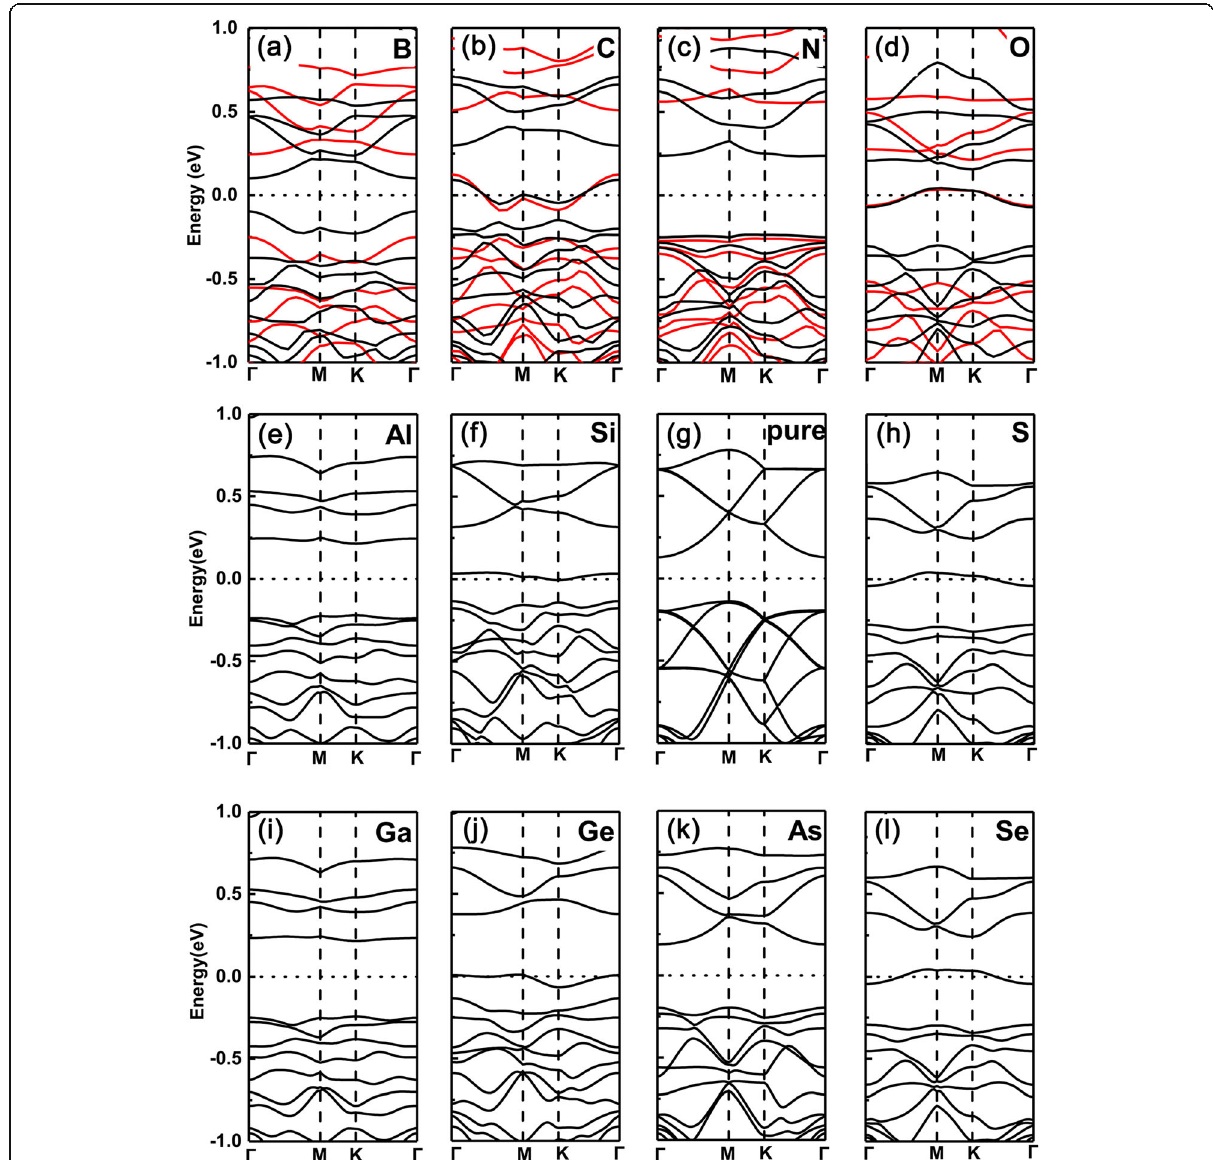
Fig. 3 Band structures of the various dopants in GeP 3 monolayer with substituting P atom. a B, b C, c N, d O, e Al, f Si, g P, h S, i Ga, j Pure GeP 3 , k As, l Se. Calculated band structures for a 2 (cid:2) 2 supercell with various dopants in GeP 3 monolayer from group III to VI, with substituting P atoms, respectively, together with that of pure GeP 3 monolayer. Both the PBE and HSE06 functionals are employed in the topmost